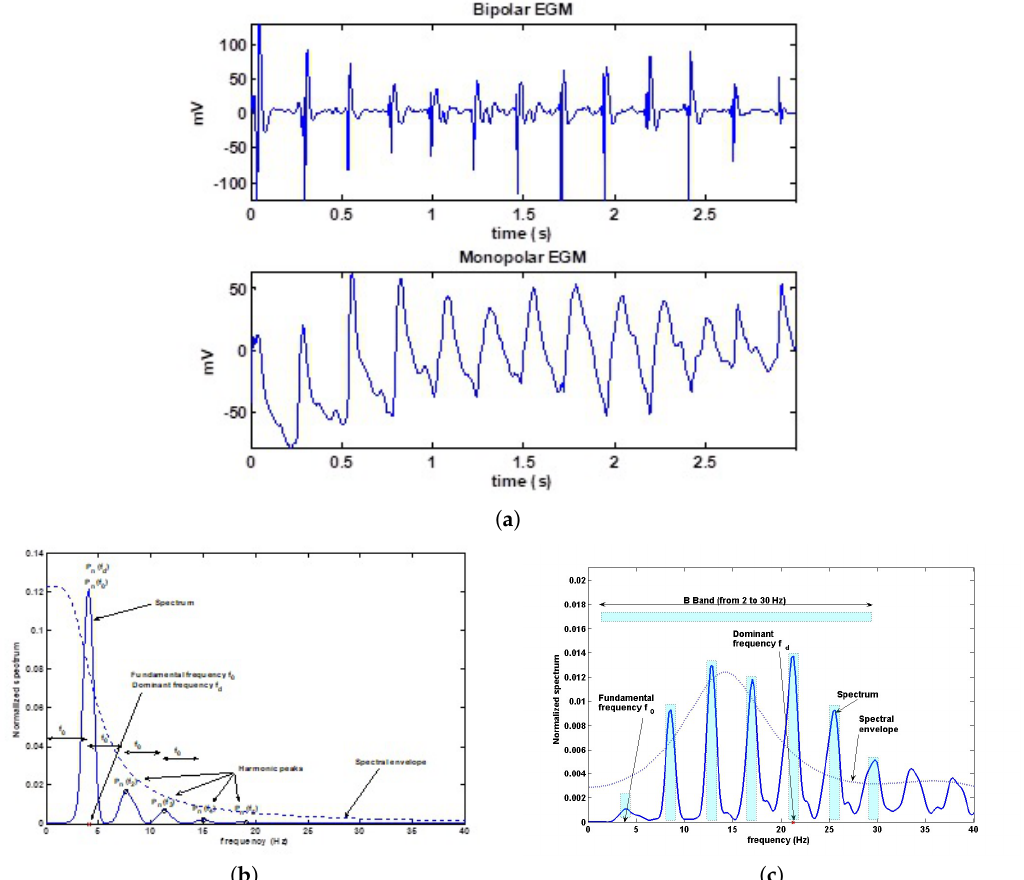
Figure 4. Example of EGM parameters in the frequency domain. ( a ) Monopolar and bipolar EGMs in the time domain. ( b ) Spectrum parameters in a typical monopolar recording. ( b ) Spectrum parameters in a typical bipolar recording. ( c ) The OI is obtained by the ratio between the power in the bandwidth of the harmonic peaks in the B band (2–30 Hz), and the total power in the